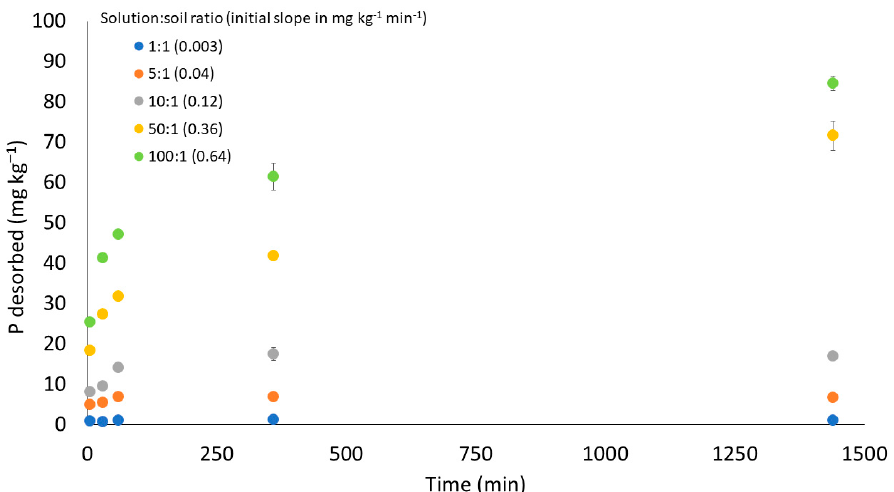
Figure 5. Phosphorus (P) batch desorption reaction order test: constant volume and variable time. Desorbed P expressed as a function of time for five different solution:soil ratios. Value in parenthesis corresponding to each ratio is the initial slope (i.e., desorption rate, mg kg − 1 min − 1 ) prior to the “breakpoint” in which the slope decreased ( p < 0.01). Error bars = standard deviation.